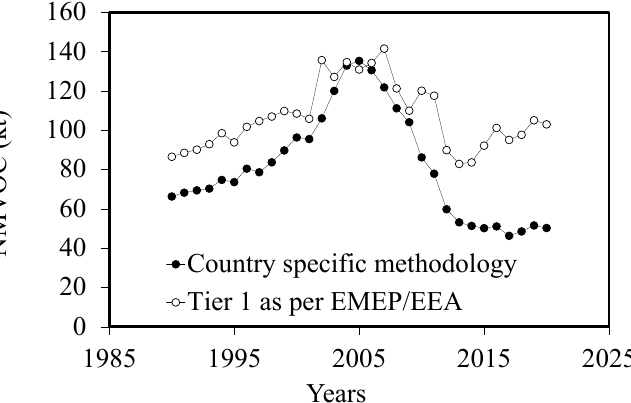
Figure 7. NMVOC emissions for the total categories, as per EMEP/EEA, for Greece.